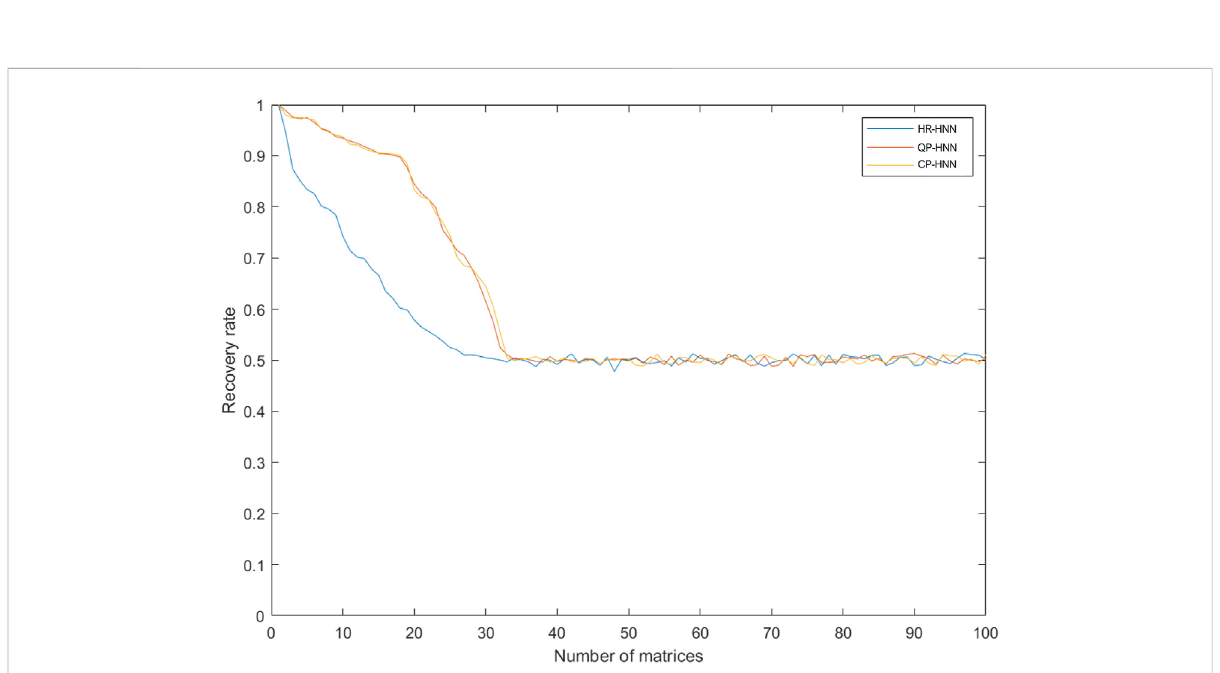
FIGURE 8 Diagram corresponding to the number of binary matrices and the recovery